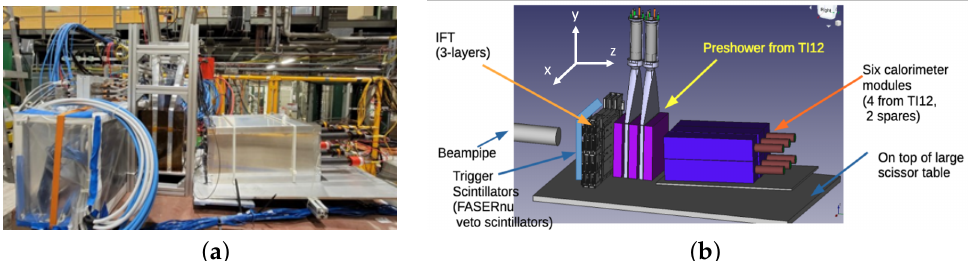
Figure 6. ( a ) A photograph and ( b ) a diagram of the test beam setup, carried out in EHN1 (Experi- mental Hall North) at CERN. The coordinate system is defined in this